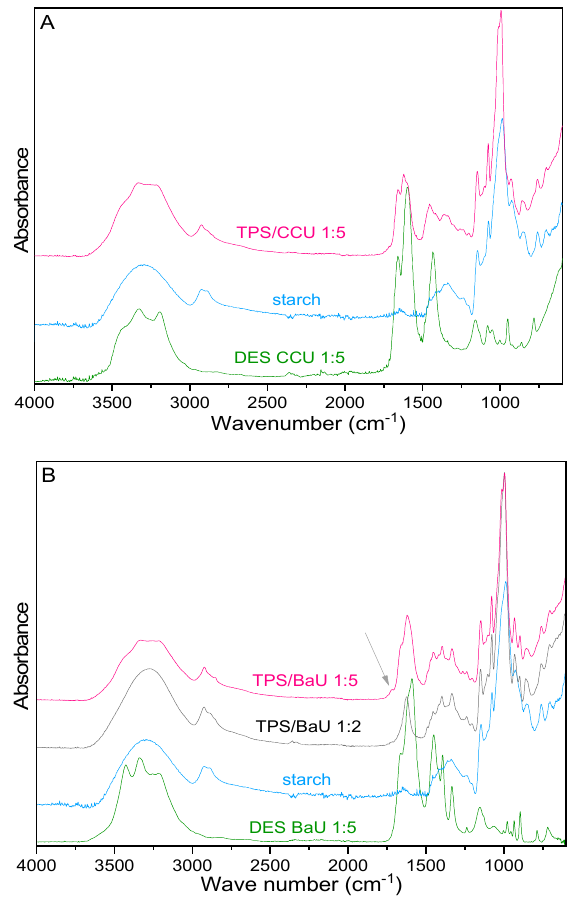
Figure 4. FTIR-ATR spectra for potato granular starch, DES and: ( A ) DES CCU 1:5 and TPS plasticized with this DES; ( B ) DES BaU at 1:2 and 1:5 molar ratio and TPS plasticized with BaU 1:5. Table 4. Swelling and solubility degrees as well as surface contact angle values of TPS films obtained via thermocompression (TPS) and extrusion and then thermocompression